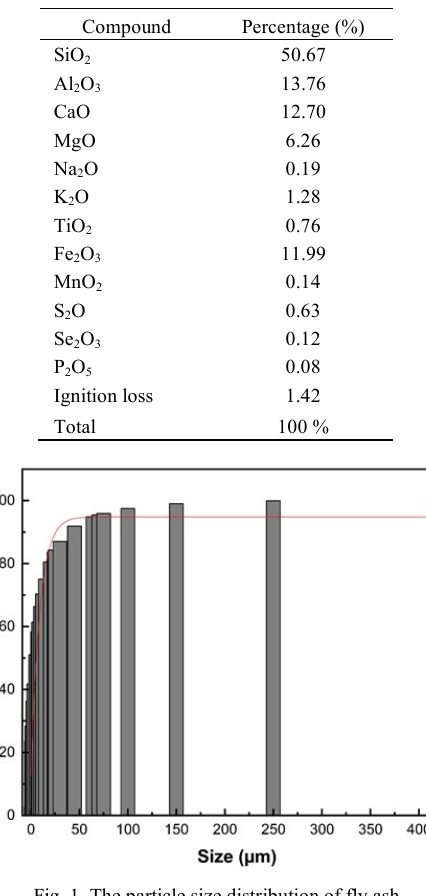
Fig. 1. The particle size distribution of fly ash